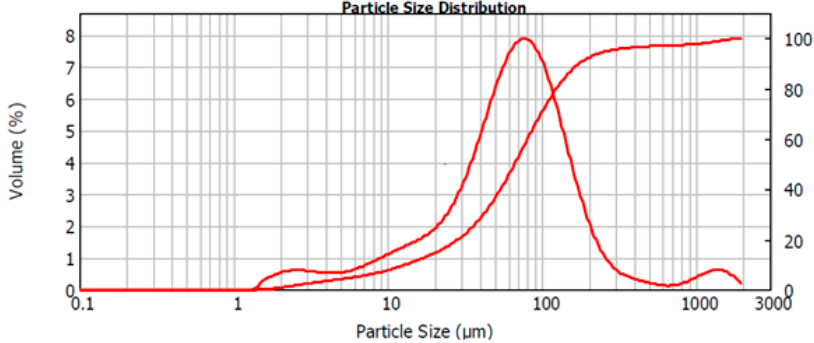
Figure 1. The observed particle size distribution of the homogenized raw material.